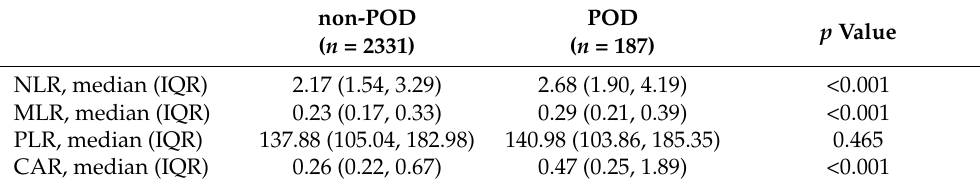
Table 2. Differences in preoperative inflammatory markers between the non-POD and POD